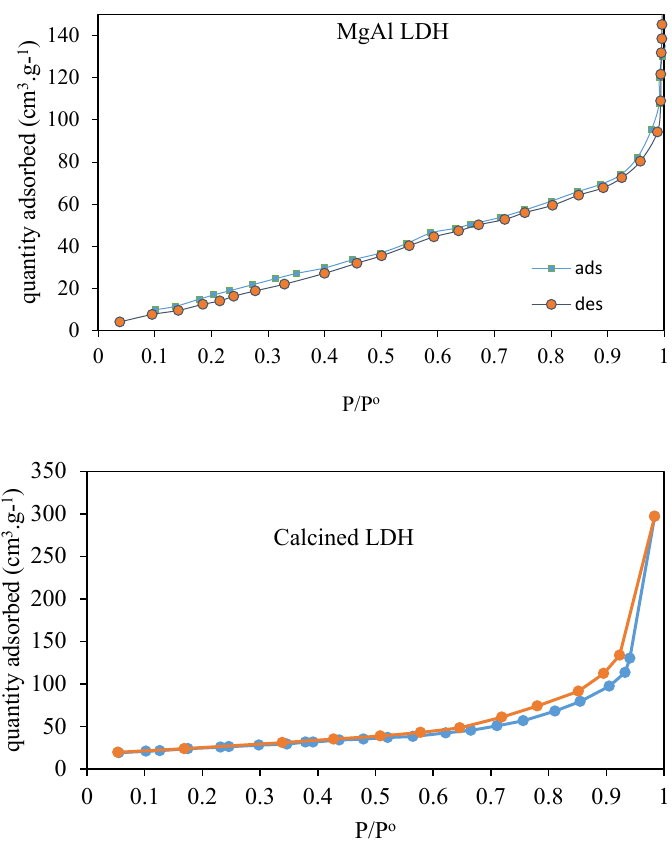
Fig.4. adsorption-desorption curves for N